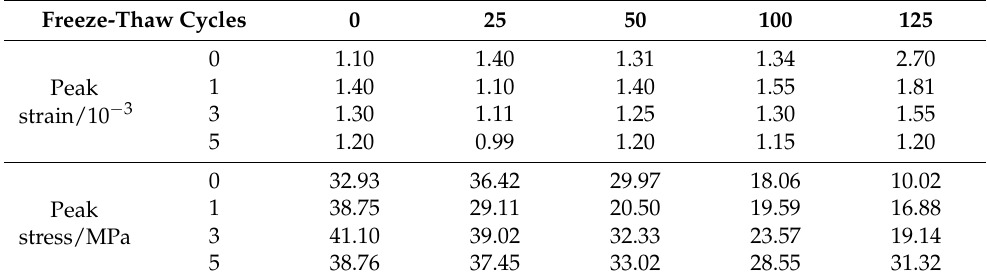
Table 5. Compressive strength of the concrete with the addition of NMK under freeze–thaw cycles. Freeze-Thaw